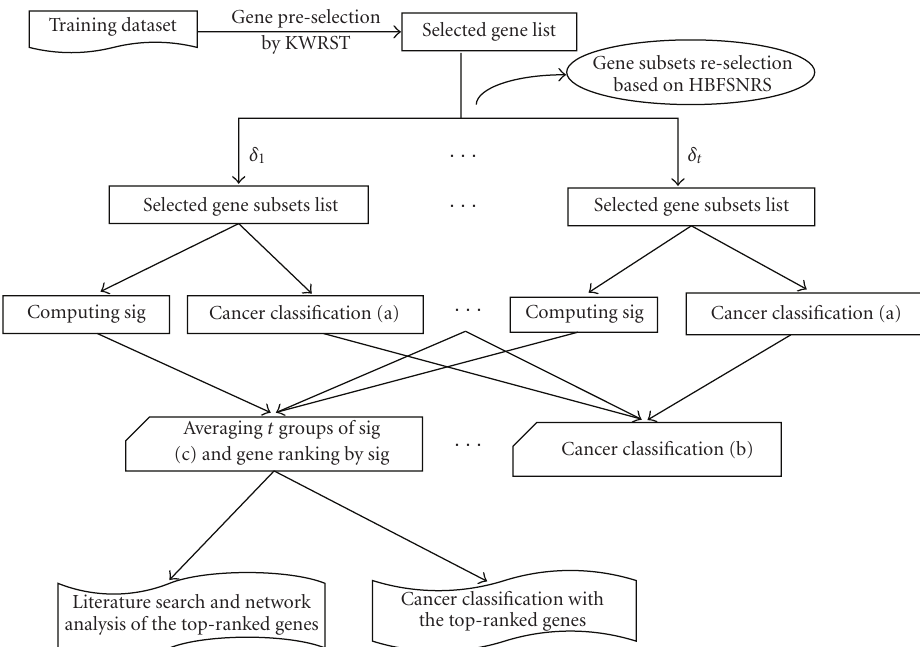
Figure 1: The framework of our analysis method. (a) An ensemble classifier was constructed on the basis of the selected genes subsets by HBFSNRS with a specific threshold value δ . (b) Another ensemble classifier was constructed based on classification results of each δ value. (c) sig denotes the significance of genes, which is defined as